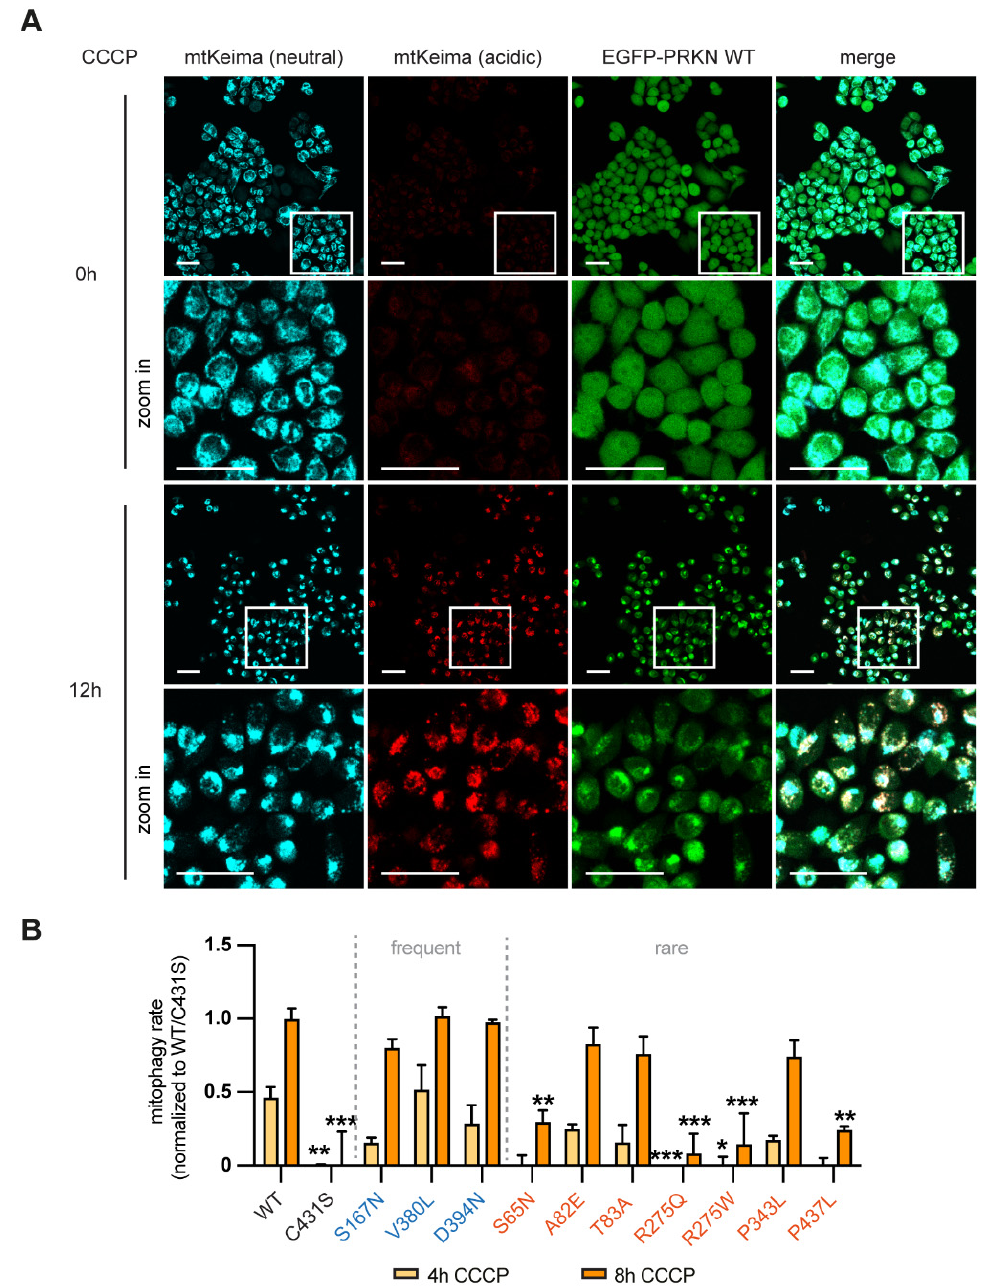
Figure 3. Analysis of mitochondrial flux in cells transfected with PRKN variants. ( A ) Representative images of HeLa cells stably expressing mtKeima and EGFP-PRKN WT with and without 12 h CCCP treatment. Images detail an increase of signal with 561 nm excitation (red, acidic mtKeima) and the presence of EGFP-PRKN clusters (green) at the mitochondria after CCCP treatments, while the signal obtained with 450 nm excitation (blue, neutral mtKeima) stays relatively consistent. Scale bars correspond to 50 µ m. ( B ) HeLa cells stably expressing mtKeima were transiently transfected with EGFP-PRKN variants, treated for 4 or 8 h with CCCP and analyzed by flow cytometry. The average ratio of excitation at 561 nm: 450 nm was calculated from the signal heights of 40,000 SYTOX Red negative and EGFP-PRKN positive cells and normalized to WT and C431S. Data is shown as the mean ± SEM of at least three independent experiments. Statistical analysis was performed using two-way ANOVA with Dunnett’s post hoc test to correct for multiple testing (* p < 0.05, ** p < 0.005, *** p < 0.0005).